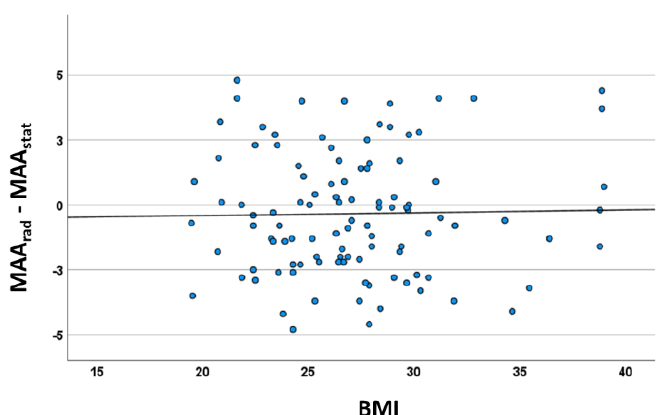
Figure 5. Correlation analysis between BMI and systematic bias (mean mechanical axis angle marker (MAA stat vs. X-ray) indicating no influence of the BMI (r s = 0.012; p = 0.903).